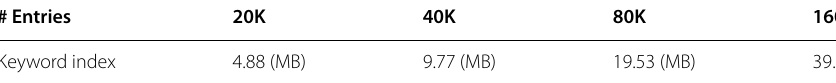
Table 2 Space consumption of encrypted index